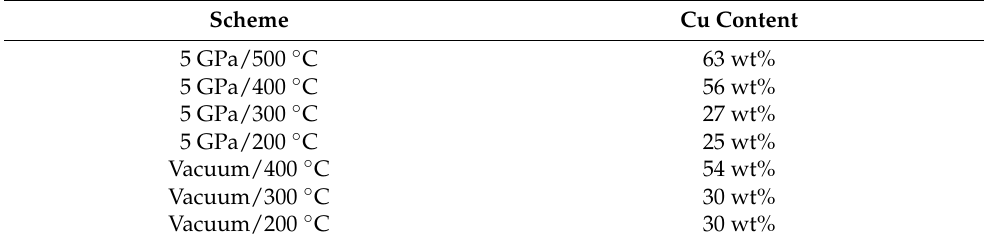
Table 1. Cu content determined by ICP-OES of MOF-derived Cu@C materials.